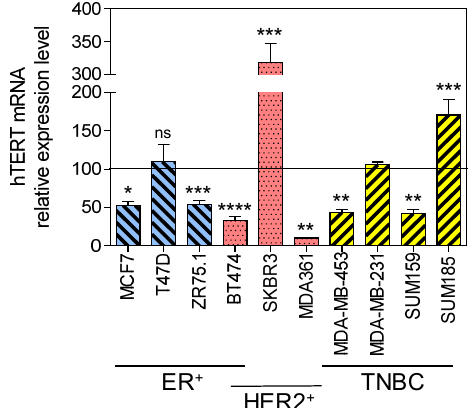
Figure 1. Constitutive hTERT gene expression in breast cancer cell lines. hTERT mRNA expression levels were determined by quantitative RT-PCR. Expression levels were normalized to the expression levels of PBGD and GAPDH housekeeping genes and to hTERT mRNA level of MDA-MB-231 cells set to 100. One-way ANOVA ( P = 0.05) Dunnett’s multiple comparison test. ER + : estrogen receptor positive, HER2 + : human epidermal receptor 2 amplified and overexpressed, TNBC: triple-negative breast cancers. * P < 0.05; ** P < 0.01;*** P < 0.001; **** P < 0.0001; ns, non-significant.